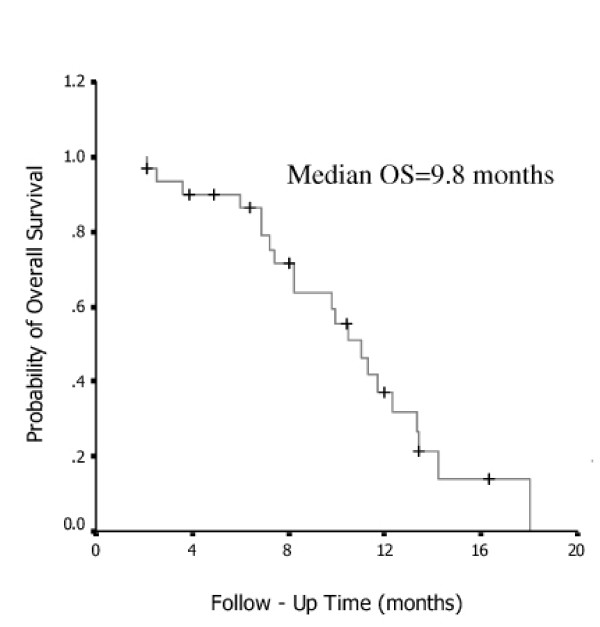
Overall survival of 33 patients treated with gefitinib.